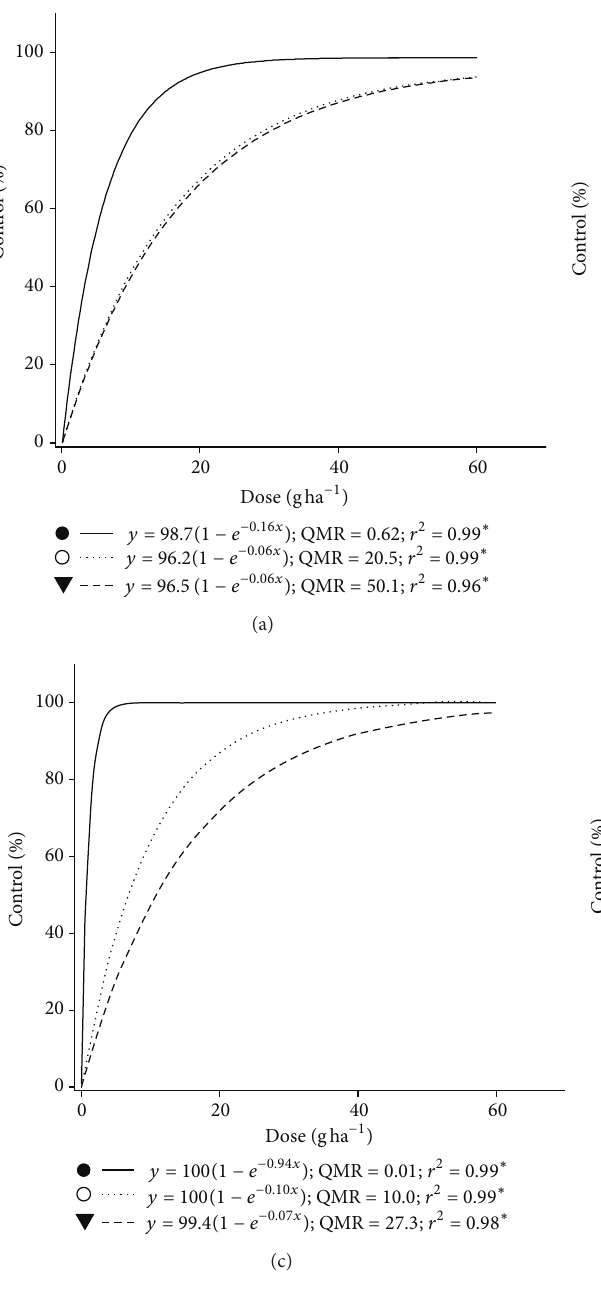
Figure 1: Control of Echinochloa sp. in irrigated rice, evaluated at 10DAT (a), 20 DAT (b), 30 DAT (c), and 81 DAT (d), depending on the starting times of irrigation ( ∙ 1 DAT, O 15DAT, and 󳶃 30DAT), penoxsulam rates, and time of application early, Rio Grande, RS ( 𝑟 2 : coefficient of determination; QMR: mean square; ∗ significant, a 𝑃 ≤ 0, 05